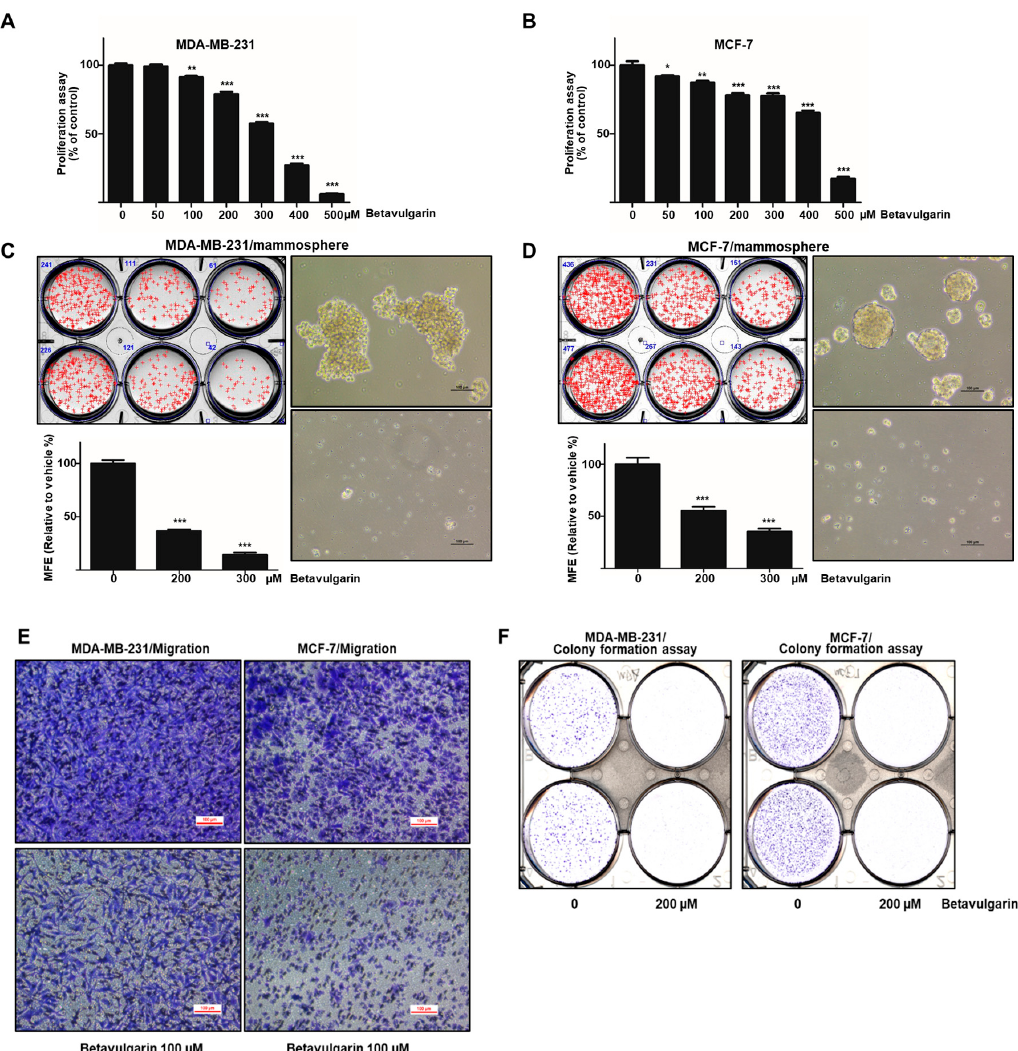
Figure 3. Effects of betavulgarin on cancer cell growth and mammosphere formation. ( A ) MDA-MB-231 cells were treated with betavulgarin in culture medium for 24 h. A cell growth assay using betavulgarin was performed with an EZ-Cytox kit. ( B ) Breast cancer MCF-7 cells were